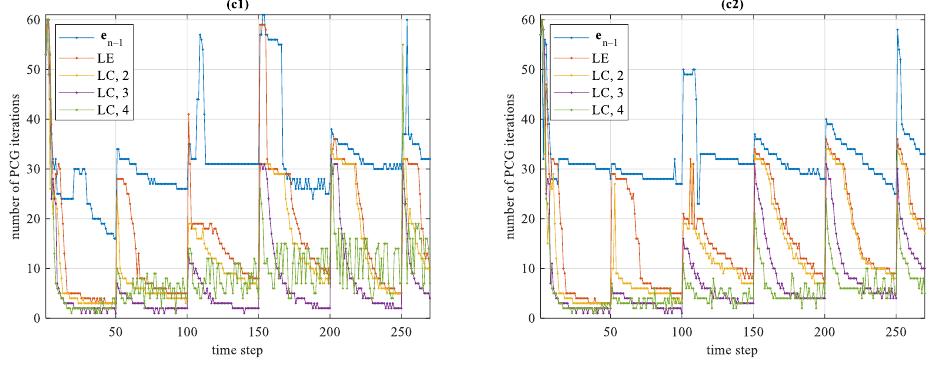
Figure 8. Example 2: efficiency comparison between SG ( left column ) and MR ( right column ) grid approaches. Abbreviations denote different initial guess ( x 0 ) approaches: (i) e n − 1 , standard approach, x 0 = e n − 1 ; (ii) LE, linearly extrapolated approach, x 0 = 2 e n − 1 − e n − 2 ; (iii) LC, N prev = 2,3,4, linearly N prev α i e n − i . Rows 1–3 show the time usage of each time step, the run combined approach, x 0 = ∑ i = 1